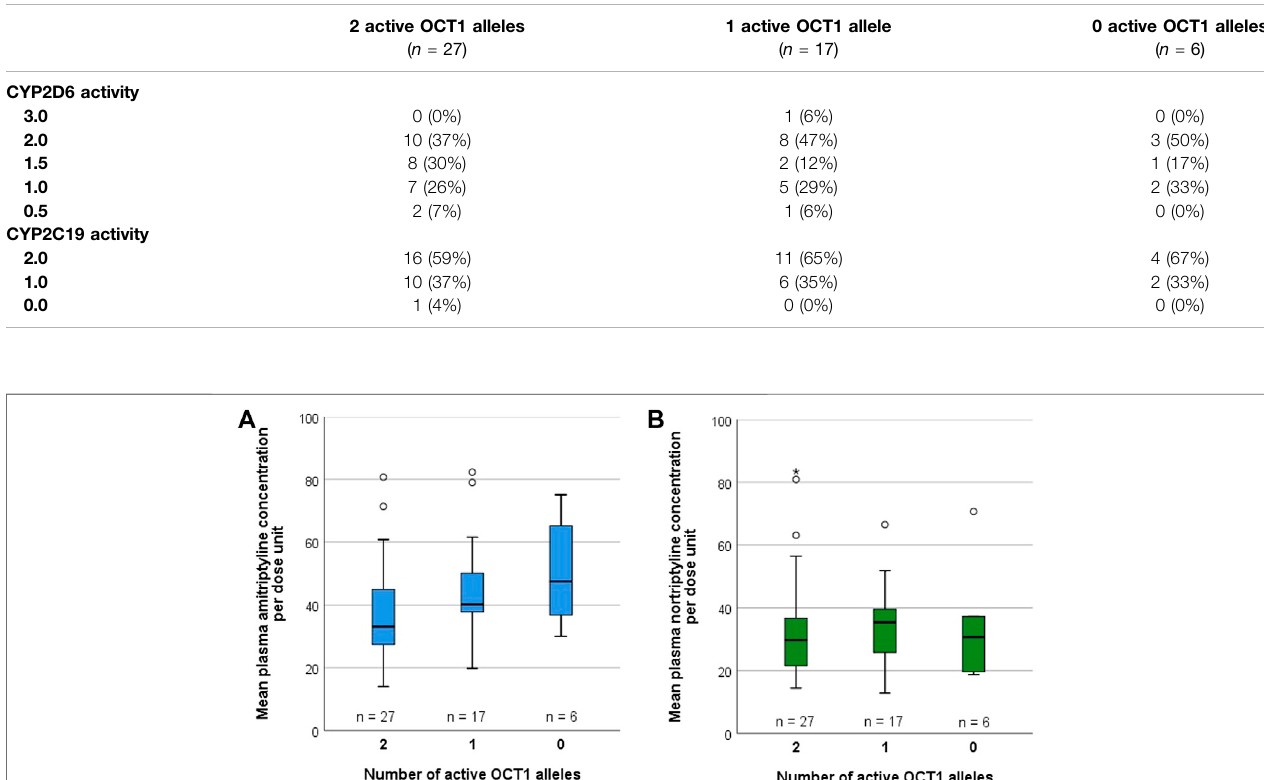
1 active OCT1 allele ( n (cid:1) 17)